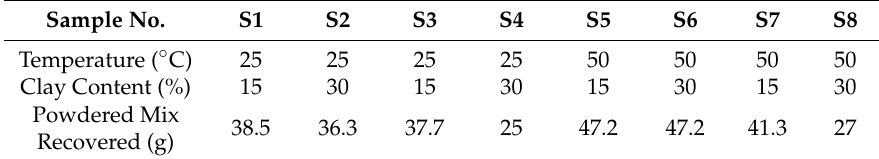
Table 2. The powdered mix of each sample recovered after filtration process.